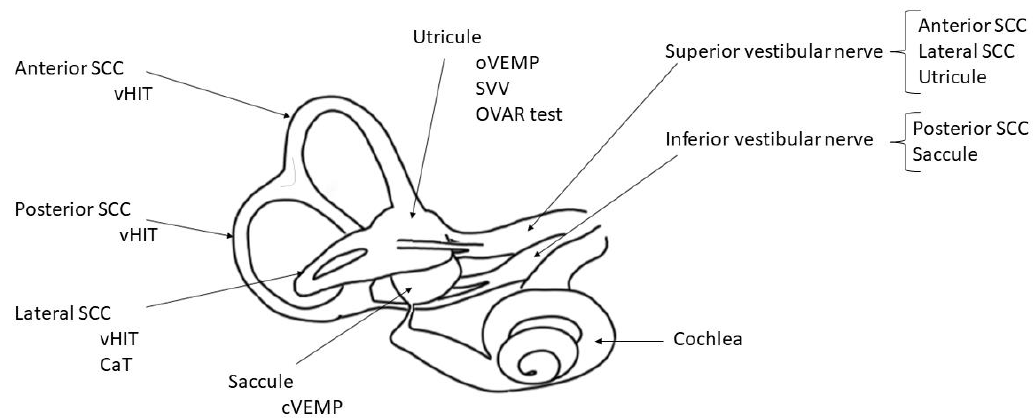
Figure 1. Inner right ear diagram with vestibular structures and their respective tests. CaT: caloric test; OVAR test: off vertical axis rotation test; SCC: semi-circular canal; SVV: subjective visual vertical; VHIT: video head impulse test; VEMPs: vestibular evoked myogenic potential (ocular and cervical).